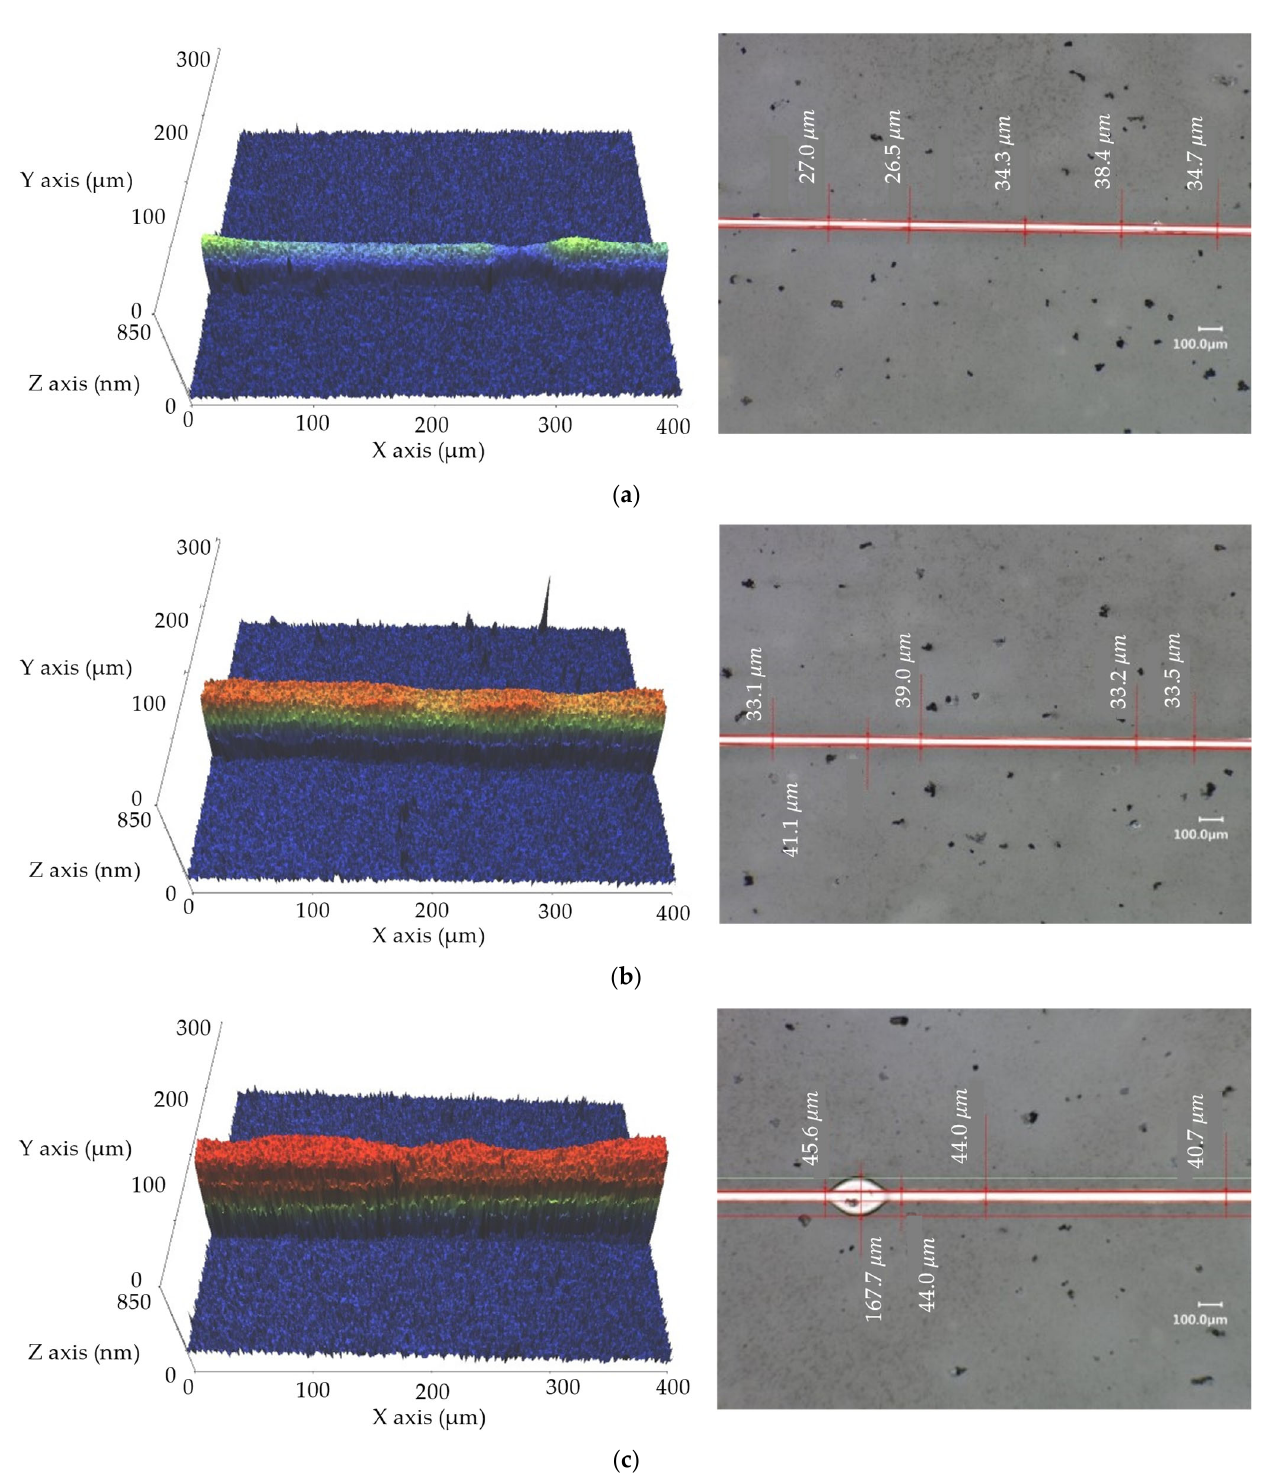
Figure 6. The 3D and 2D profiles of printed silver lines with laser ablation width of 40 µ m and various inkjet drop spacings: ( a ) 20 µm, ( b ) 10 µm, and ( c ) 5 µm.